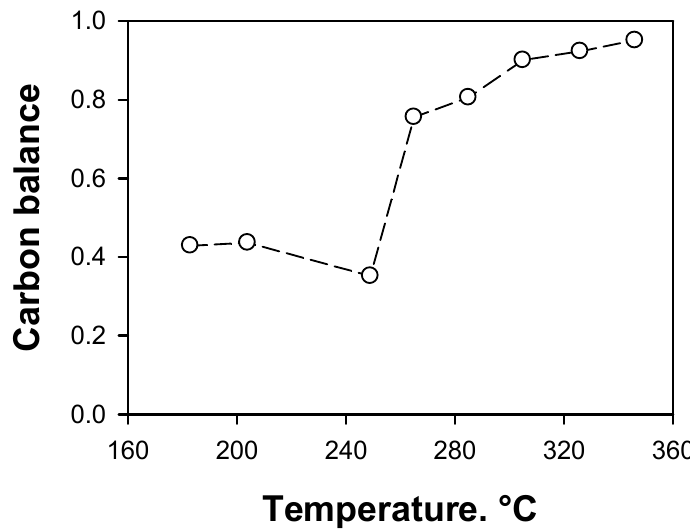
Figure 9. Carbon balance as a function of temperature on VOP / Al. τ = 0.057 g · s · cm − 3 ; Gly / H 2 O / O 2 / N 2 = 2 / 41 / 6 / 51 vol. %.